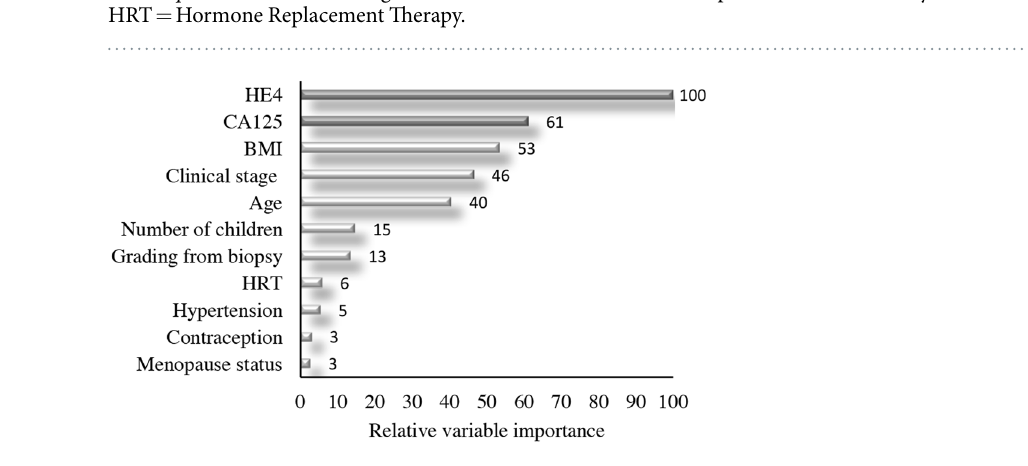
Figure 1. Relative variable importance measure. Total Decrease in Node Impurity- obtained by Random Forests on all 293 EC